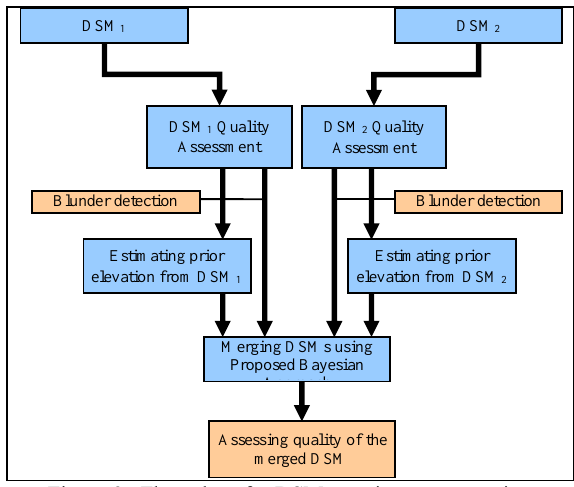
Figure 3. Flow chart for DSM merging process using Bayesian